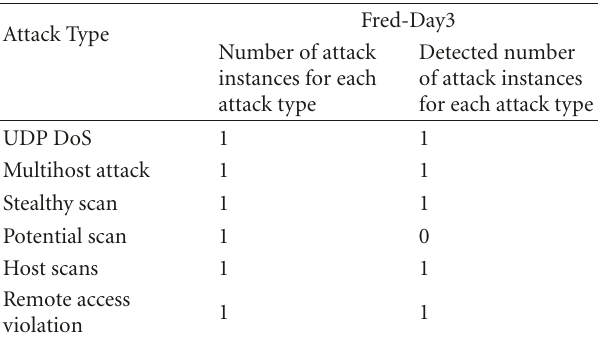
Table 10: Number of attack instances detected for each attack type for Fred-Day3.